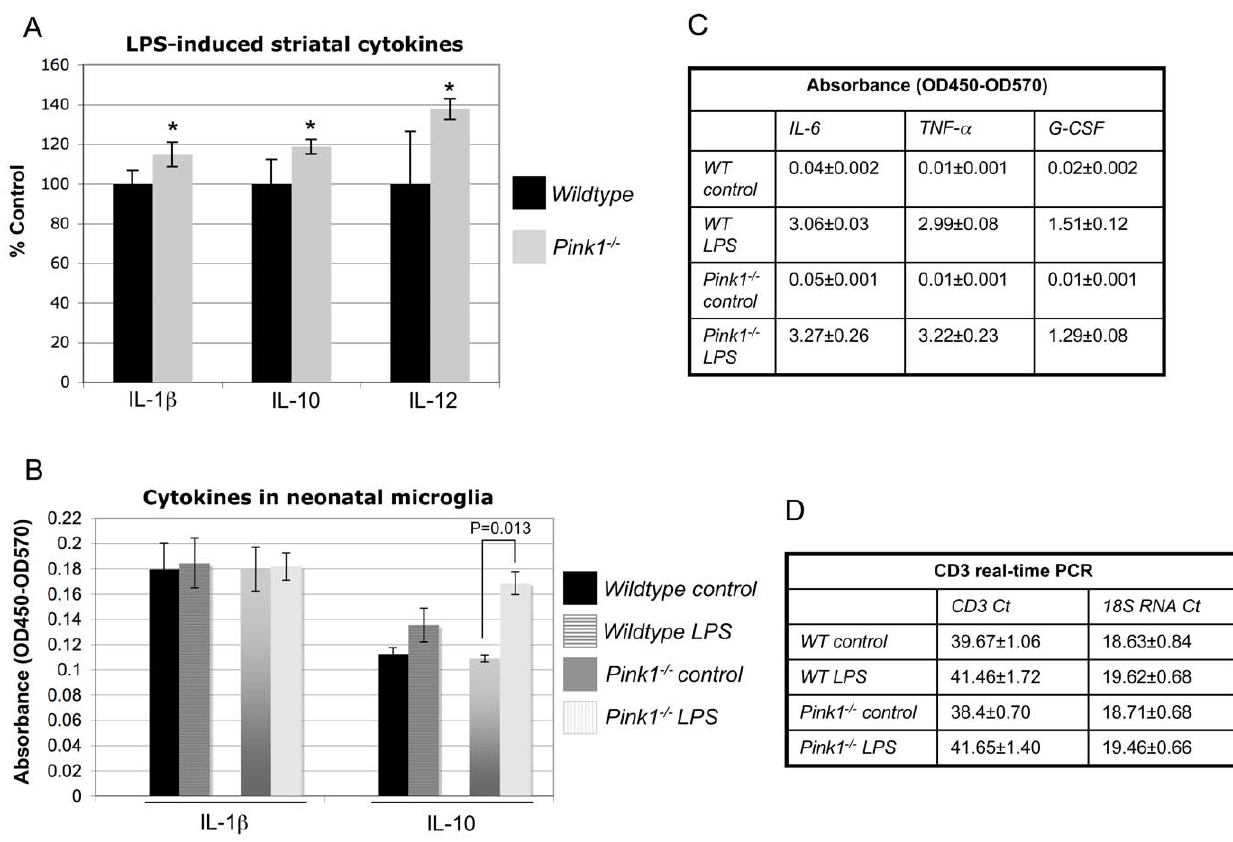
Figure 8. Cytokine expression in the striatum and isolated microglial cultures. (A) Wildtype and Pink1 2 / 2 mice (n=4 mice/genotype) were injected ip with 0.33 m g LPS/g body weight. Cytokines in striatal homogenates (corresponding to 100 m g total protein) were measured eight hours later by ELISA as described in the Materials and Methods. * P , 0.05, compared to wildtype mice. Basal cytokine levels, measured in a separate experiment, were not statistically different between wildtype and Pink1 2 / 2 mice. (B) Microglial cultures derived from the forebrain of neonatal wildtype and Pink1 2 / 2 mice were incubated with 100 ng/ml LPS for 24 hours in 24-well plates and the cytokines were measured with an ELISA as described in the Methods (n=8 wells per condition). (C) Strong induction of IL-6, TNF- a and G-CSF in wildtype and Pink1 2 / 2 microglia cells demonstrates that the cells were capable of responding to the LPS stimulus. In panels B and C, background-corrected absorbance is plotted (OD450 minus OD570). (D) Real-time PCR expression analysis of CD3 mRNA (specific T cell marker) in the striatum of control and LPS-treated wildtype and Pink1 2 / 2 mice, showing that the T cell marker is barely detectable (Ct values of 39.67 and 38.46) and not increased by LPS treatment.